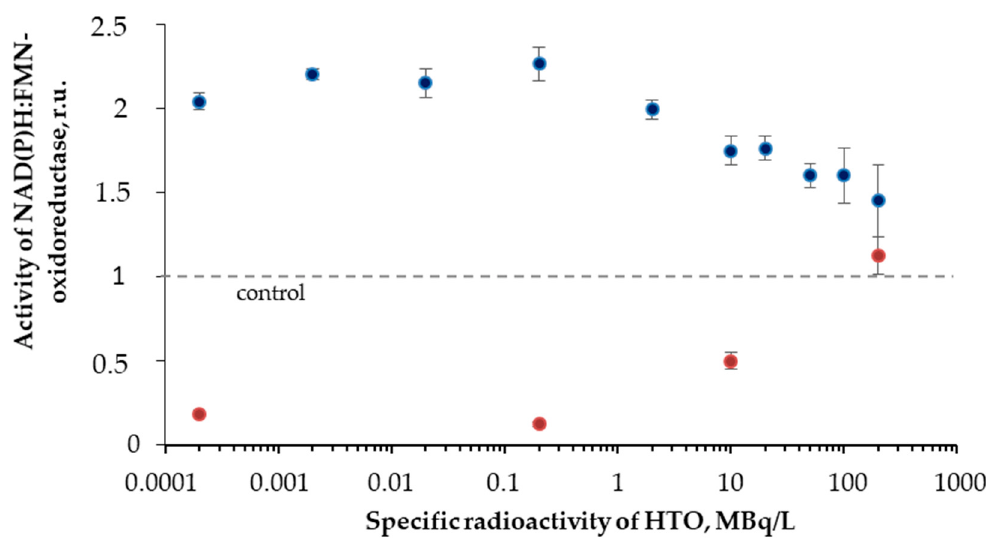
Figure 7. Activity of NAD(P)H:FMN-oxidoreductase vs. HTO specific radioactivity. Time of exposure was 1 min (blue) and 110 min (red).